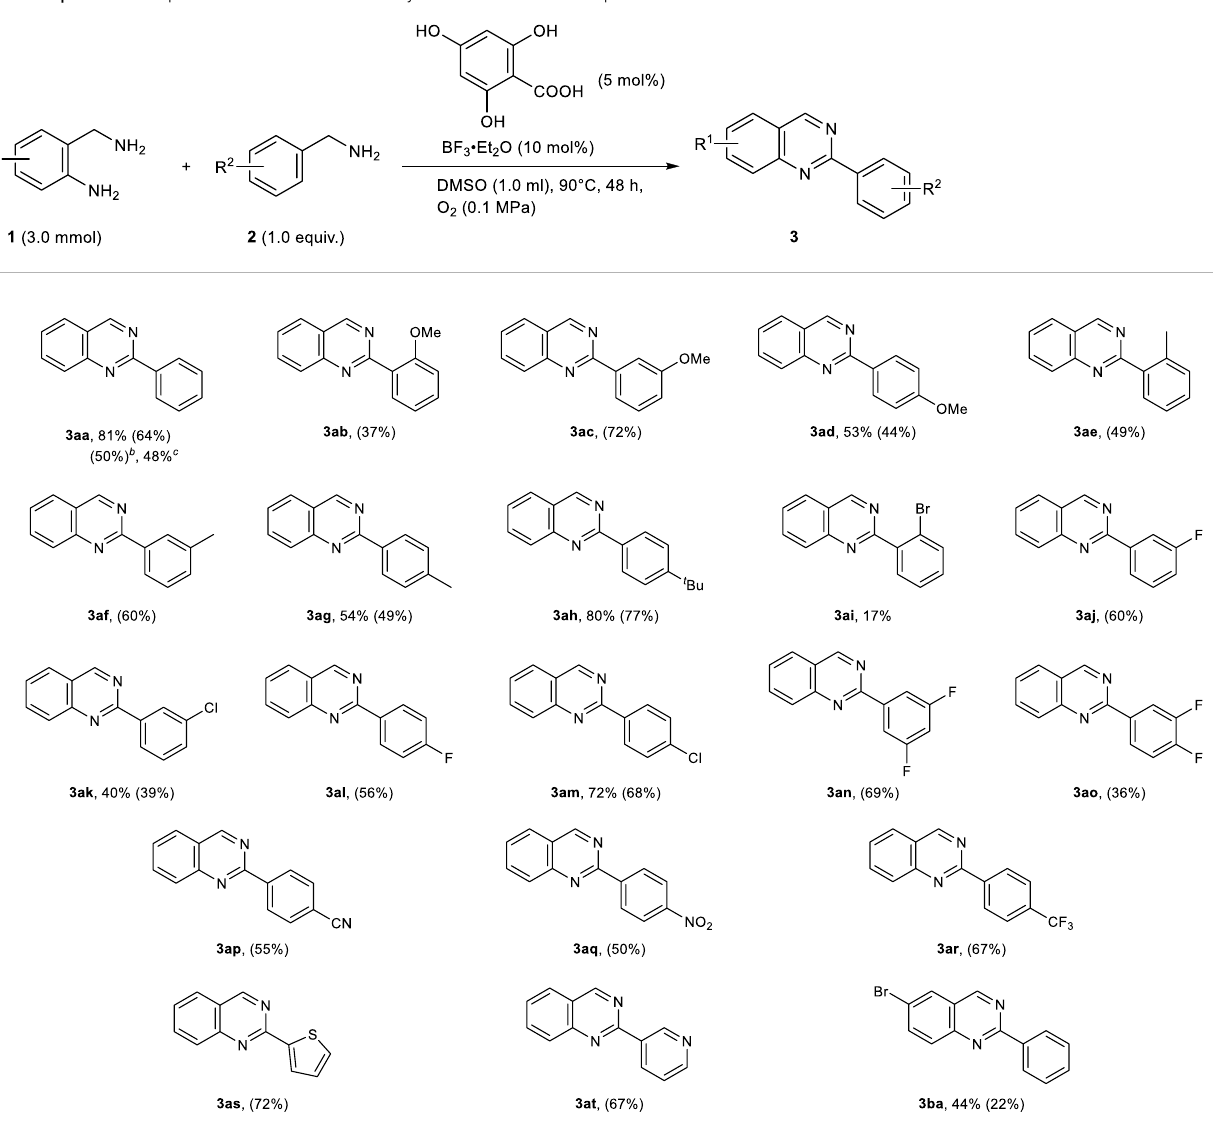
a Yields were determined by 1 H NMR spectroscopy (isolated yields). b Reaction conditions: 1a (10.0 mmol), 2a (1.0 equiv.), 4,6-dihydroxysalicylic acid (5 mol%), BF 3 · Et 2 O (10 mol%), DMSO (2.5 ml), 90 ° C, 48 h, O 2 (0.1 MPa). c Reaction conditions: